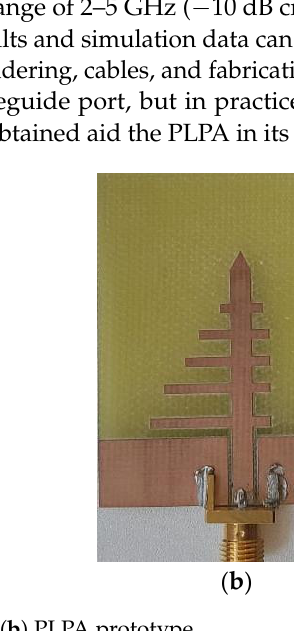
Figure 4. ( a ) LPKF (S103) protomat and ( b ) PLPA prototype.